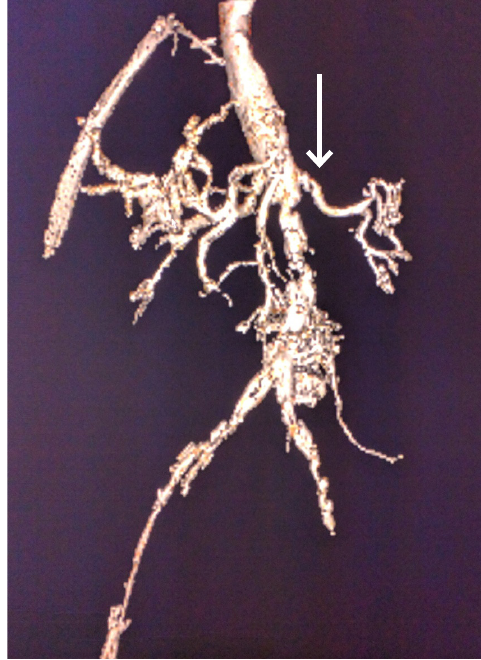
Image 2 . Computed tomography angiography of the abdominal aorta and bilateral lower extremities with runoff in three-dimen- sional reconstruction. Severe narrowing at the origin of the left renal artery is visible (arrow).